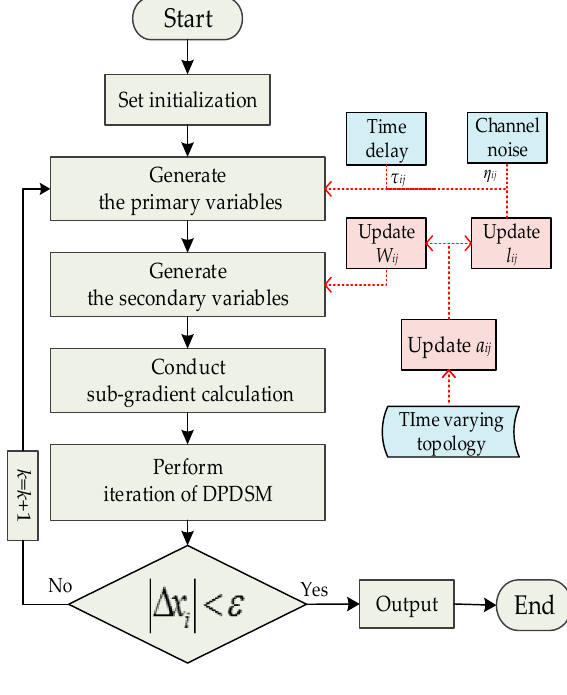
Figure 1. Flowchart of DPDSM.